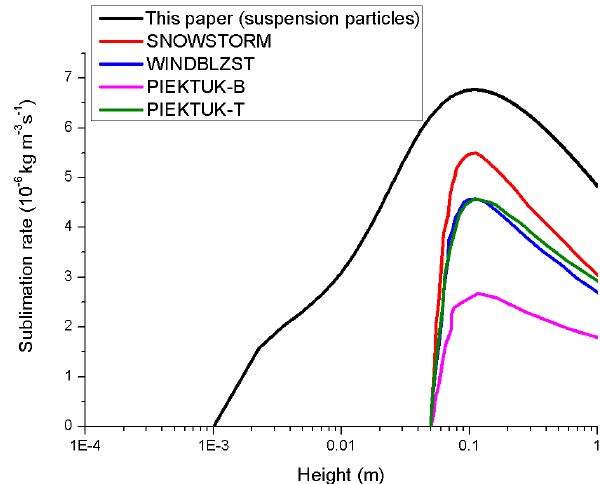
Figure 4. Comparison of sublimation rate for this paper and four blowing snow models (Xiao et al., 2000). The friction velocity is set to 0.89ms − 1 , and the temperature is set to